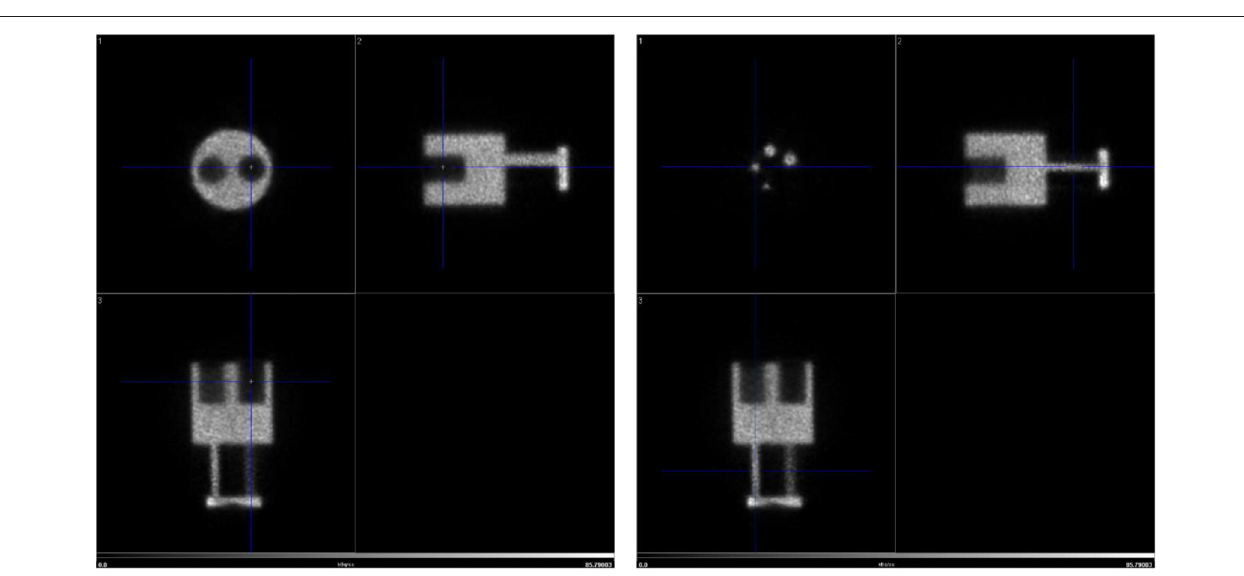
FIGURE 5 | IQ Phantom images acquired over 20 min with < 1